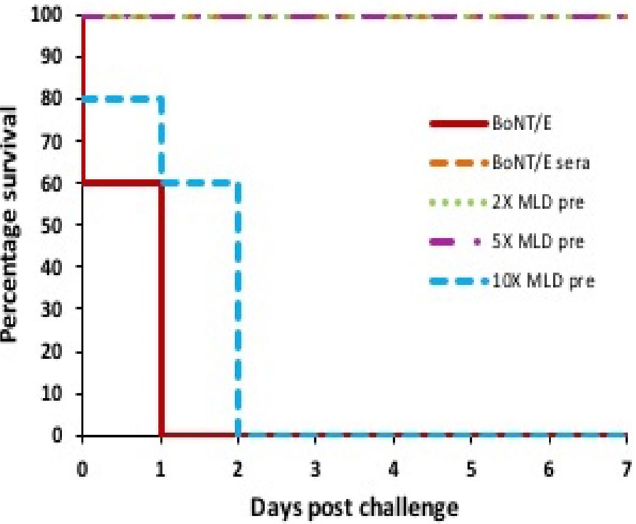
Figure 7. In vitro neutralization study: The naïve BALB/c mice were injected with BoNT/E (brown), BoNT/E sera alone (orange), pre-incubated mixture of vaccinated mice sera: with 2x (green), 5x (purple) and 10x MLDs (blue). This graph illustrates the animals examined for 7 days for their